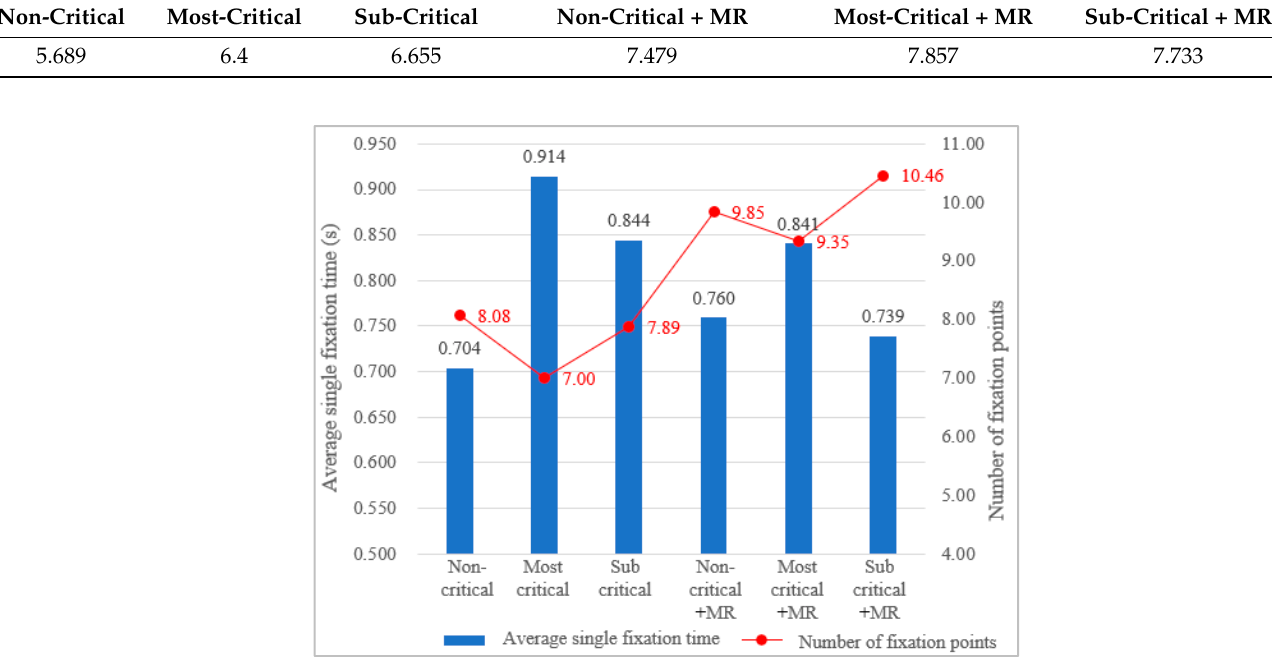
Figure 9. Number of fixation points in the front road area and average single fixation time.